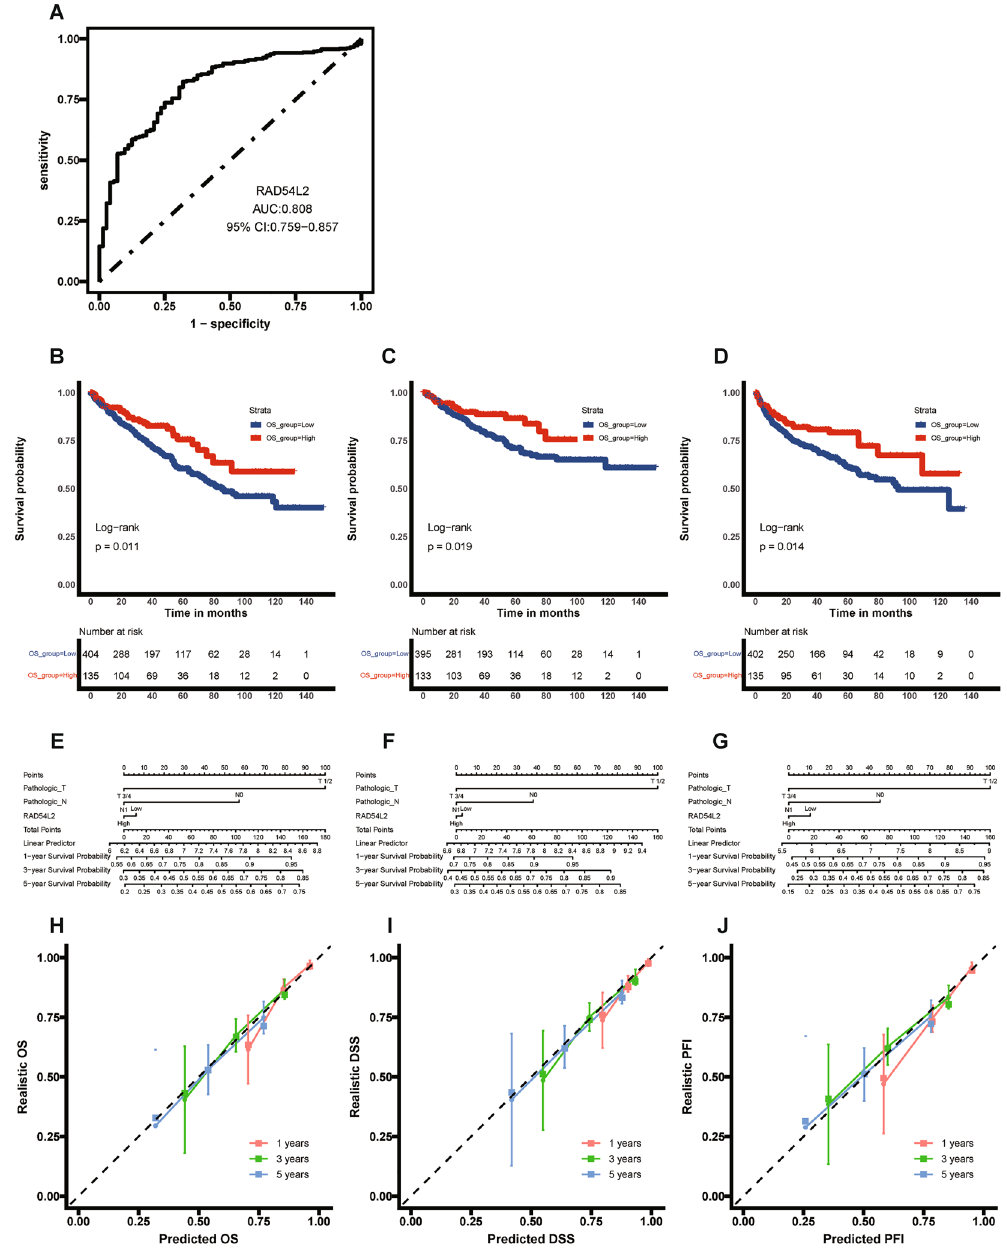
Figure 6. Predictive value of Rad54l2 for RCC diagnosis and prognosis. ( A ) The value of Rad54l2 for RCC diagnosis was analyzed by Receiver operating characteristic (ROC) curve. ( B – D ) K–M curve for OS, DSS and PFI between Rad54l2-high and Rad54l2-low groups. ( E – G ) Rad54l2-based risk scoring models for 1-, 3-, and 5-year OS, DSS and PFI were constructed in nomograms. ( H – J ) Calibration curves were drawn to test the efficiency of the corresponding nomograms for OS, DSS and